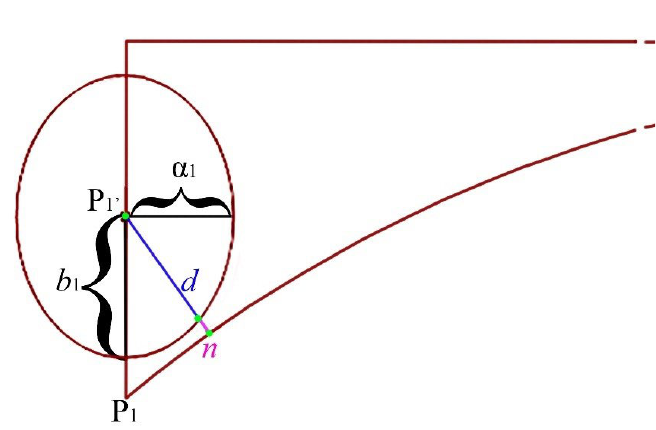
Figure 7. Distance between Void N.1 and arch of the circumference.